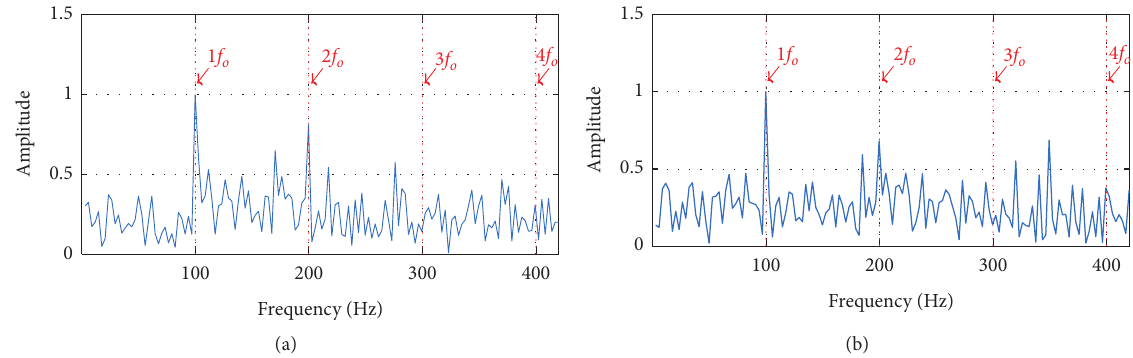
Figure 8: Results of the combined method using traditional wavelet threshold and Fast-SC. (a) Soft wavelet threshold and Fast-SC. (b) Hard wavelet threshold and